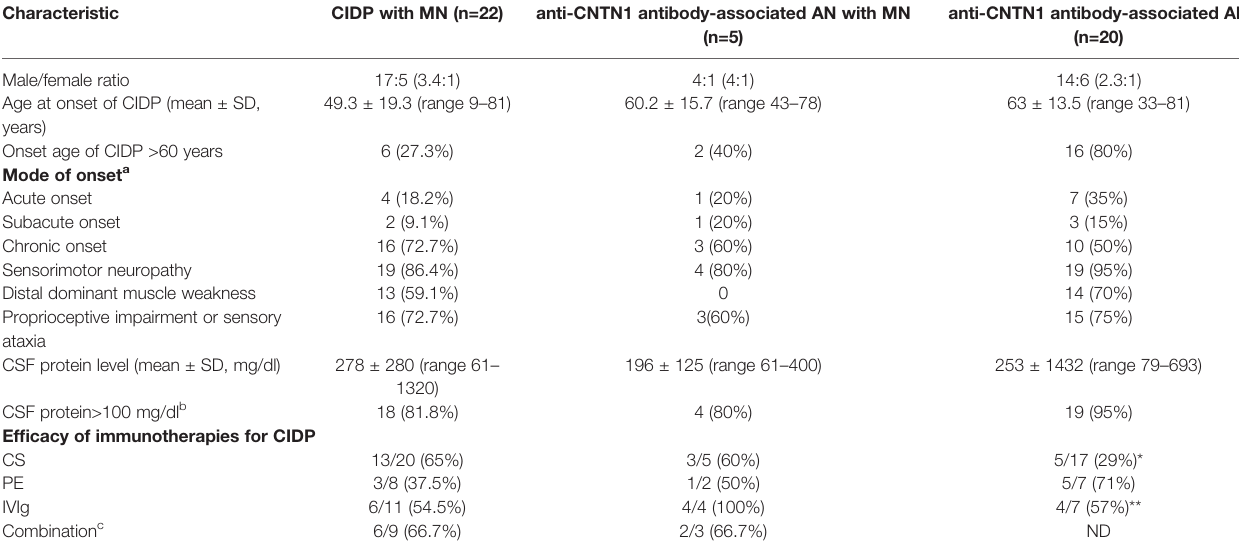
TABLE 3 | Comparison of the clinical characteristics of chronic in fl ammatory demyelinating polyneuropathy (CIDP) with membranous nephropathy (MN), anti-contactin 1 (CNTN1) antibody-positive AN with MN, and anti-CNTN1 antibody-associated AN. Characteristic CIDP with MN (n=22) anti-CNTN1 antibody-associated AN with MN